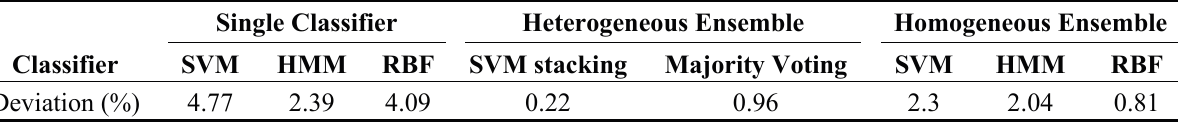
Table 3. Standard deviation of accuracy for different